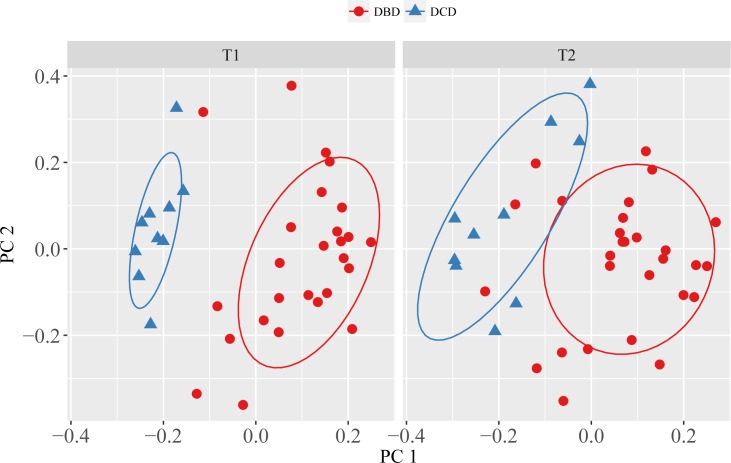
Principal component analysis scores plots highlighting the metabolic separation of the DBD and DCD grafts in the cold phase (T1) and separately the post-reperfusion phase (T2), based on analyses of just the 50 and 64 peaks identified as being significantly different (between DBD and DCD) for the T1 and T2 groups, respectively.Variance explained for T1, PC1 = 36.75% and PC2 = 19.39% and for T2, PC1 = 25.22% and PC2 = 17.41%.